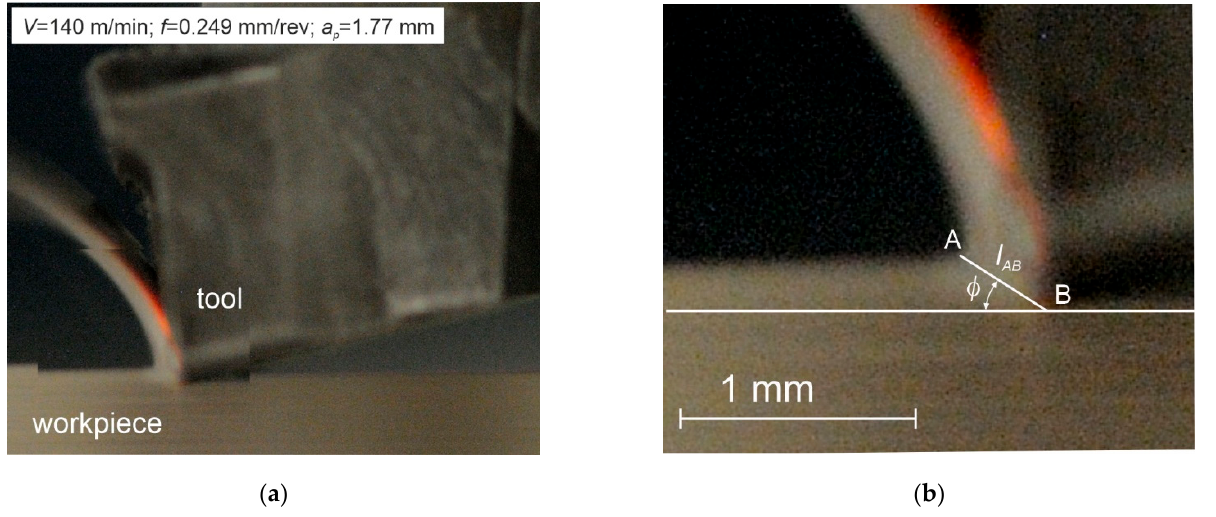
Figure 6. ( a , b ) Examples of the chip forming photographs for V = 140 m/min, f = 0.249 mm/rev, a p = 1.77 mm.